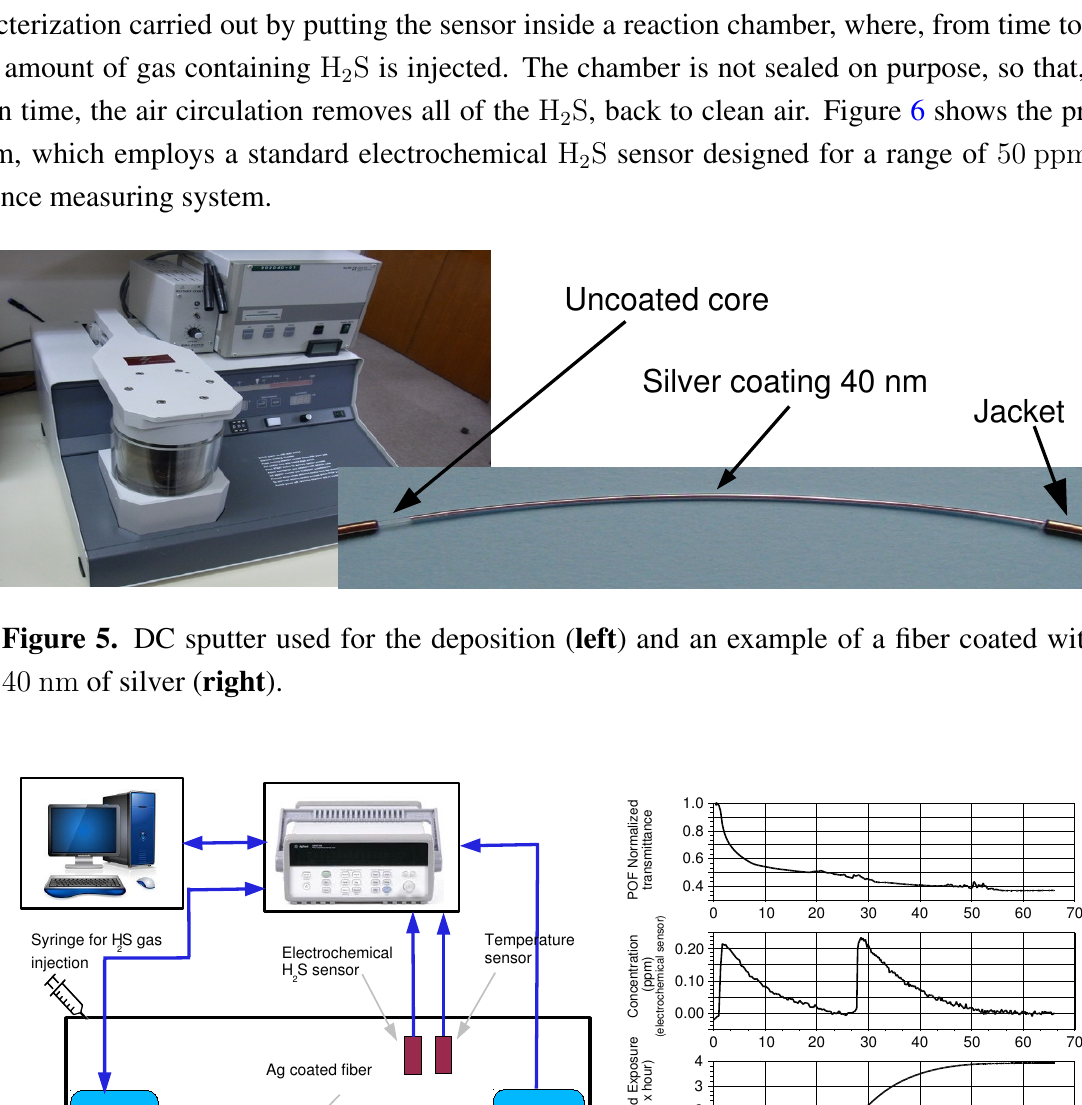
Figure 6. Setup used for characterizing the H obtained during the test ( right